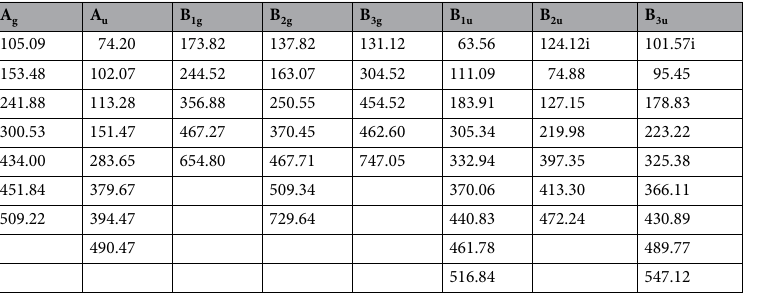
Table 4. The frequencies (cm − 1 ) of zone-center optical phonon modes in the perovskite (Pv)-type ZnTiO 3 .